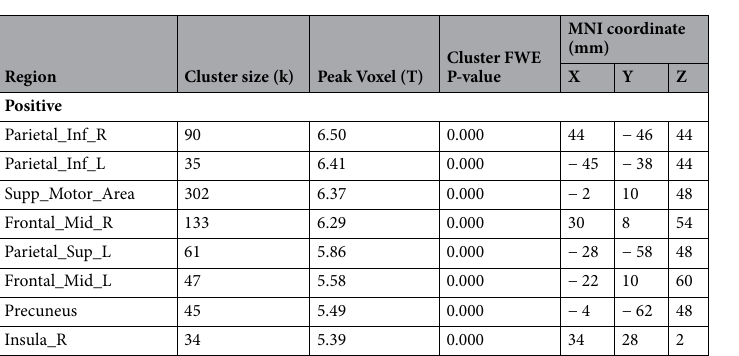
Region Cluster size (k) Peak Voxel (T)